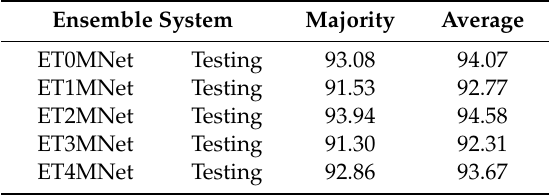
Table 14. Classification performance of ensemble deep models designed by the pre-trained CNNs.